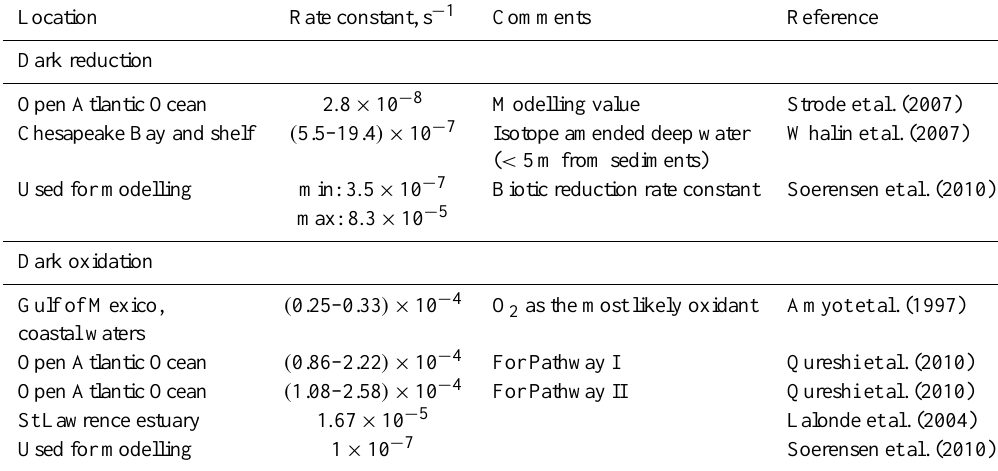
Table 3. Rate constants of mercury dark reduction and oxidation in